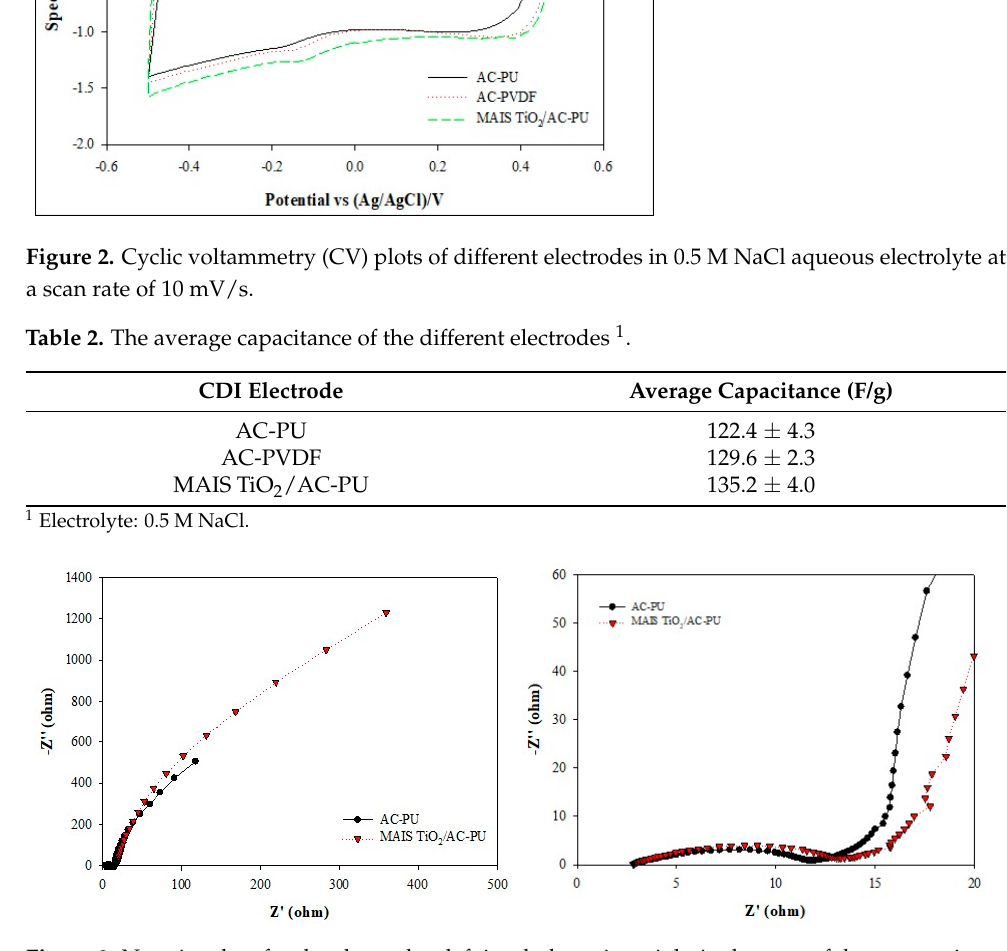
Figure 2. Cyclic voltammetry (CV) plots of different electrodes in 0.5 M NaCl aqueous electrolyte at a scan rate of 10 mV/s. Table 2. The average capacitance of the different electrodes 1 .